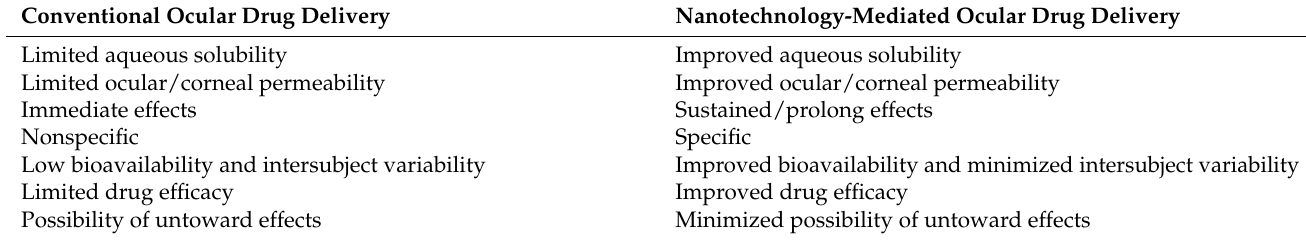
Table 1. Comparative advantages of nanotechnology-mediated ocular drug delivery in respect to conventional ocular drug